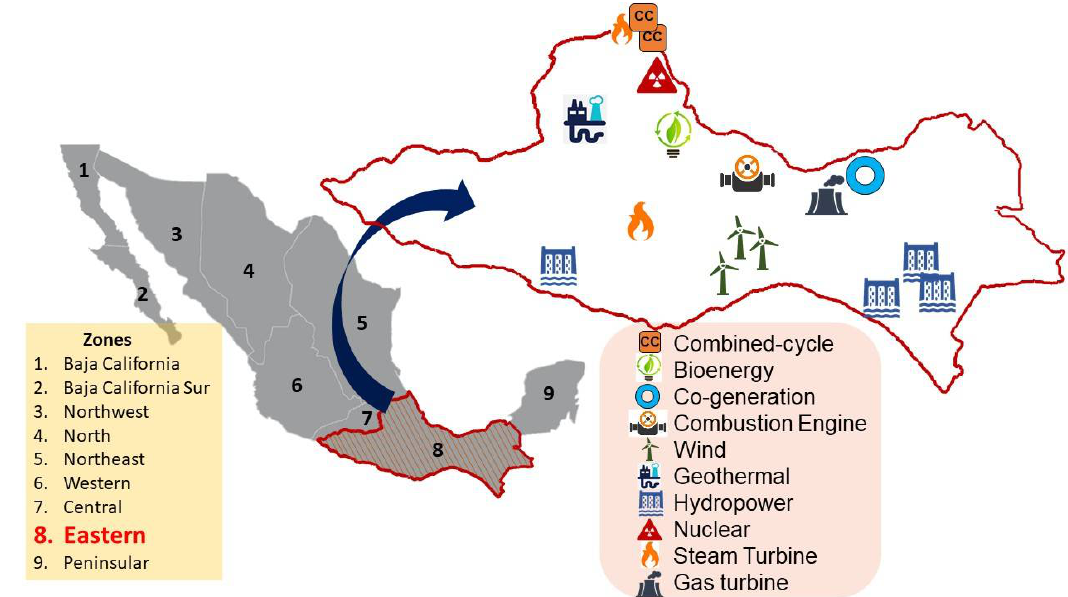
Figure 10. The geographical location of the 17 analyzed power plants in the eastern zone of Mexico.